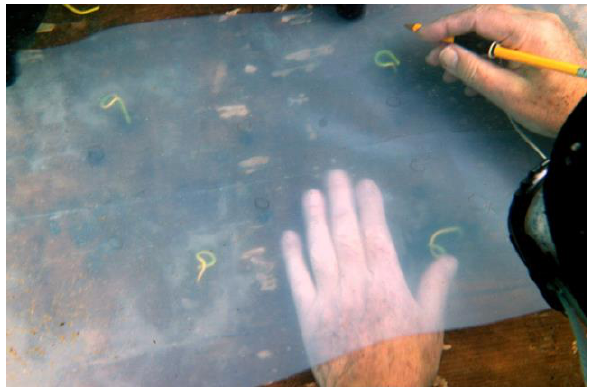
Figure 4: Caesarea shipwreck (excavation 2017): hand drawing of a planking joint with mylar paper. Note the green and yellow electric cords, that mark the location of the tenons (photo: Ariel Aba Eli/Caesarea Shipwreck